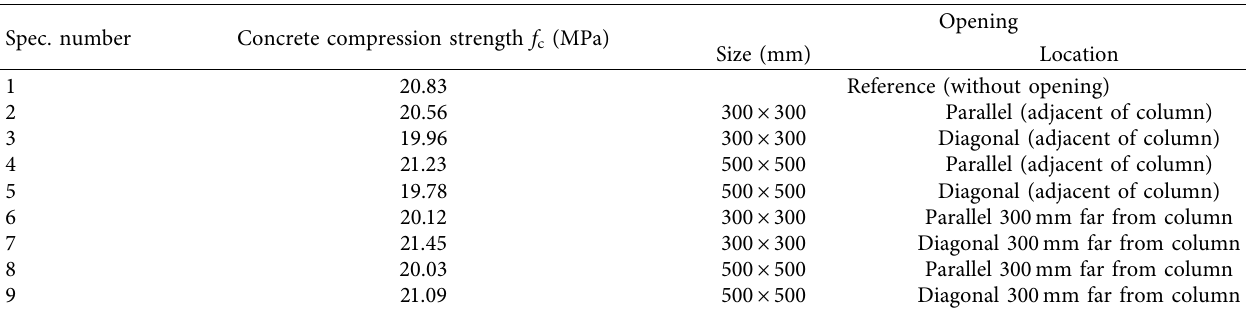
Table 2: Features of the concrete used in the samples